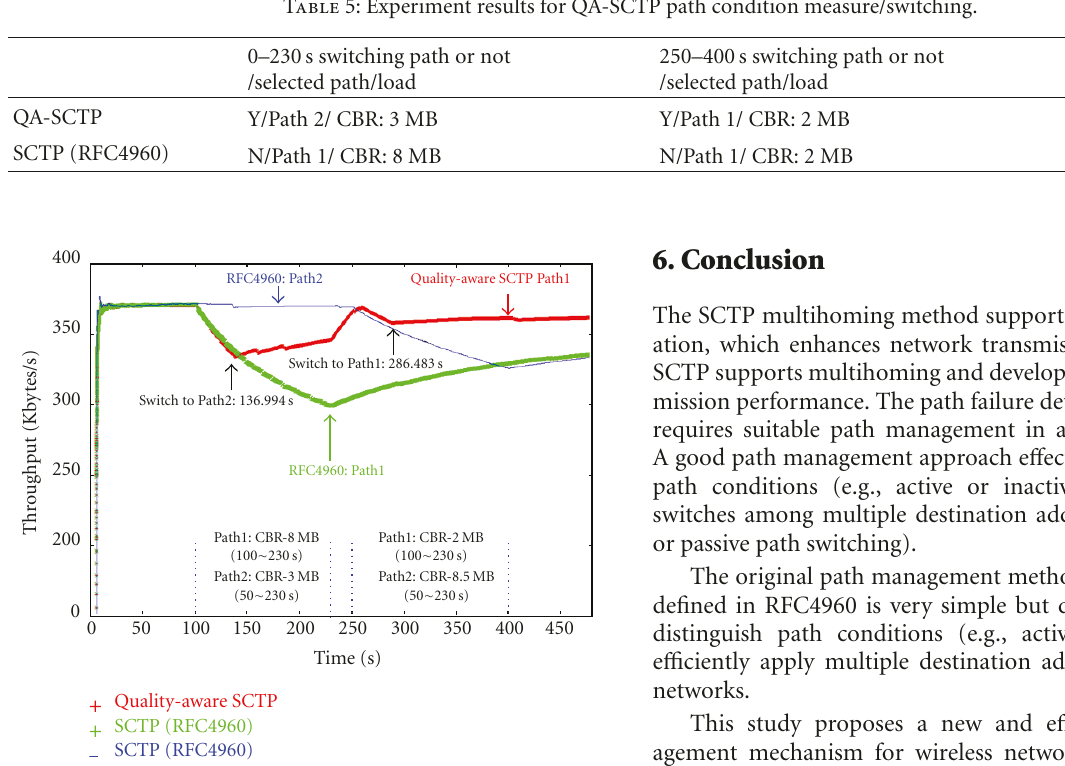
Figure 18: QA-SCTP path condition measure/switch experiment